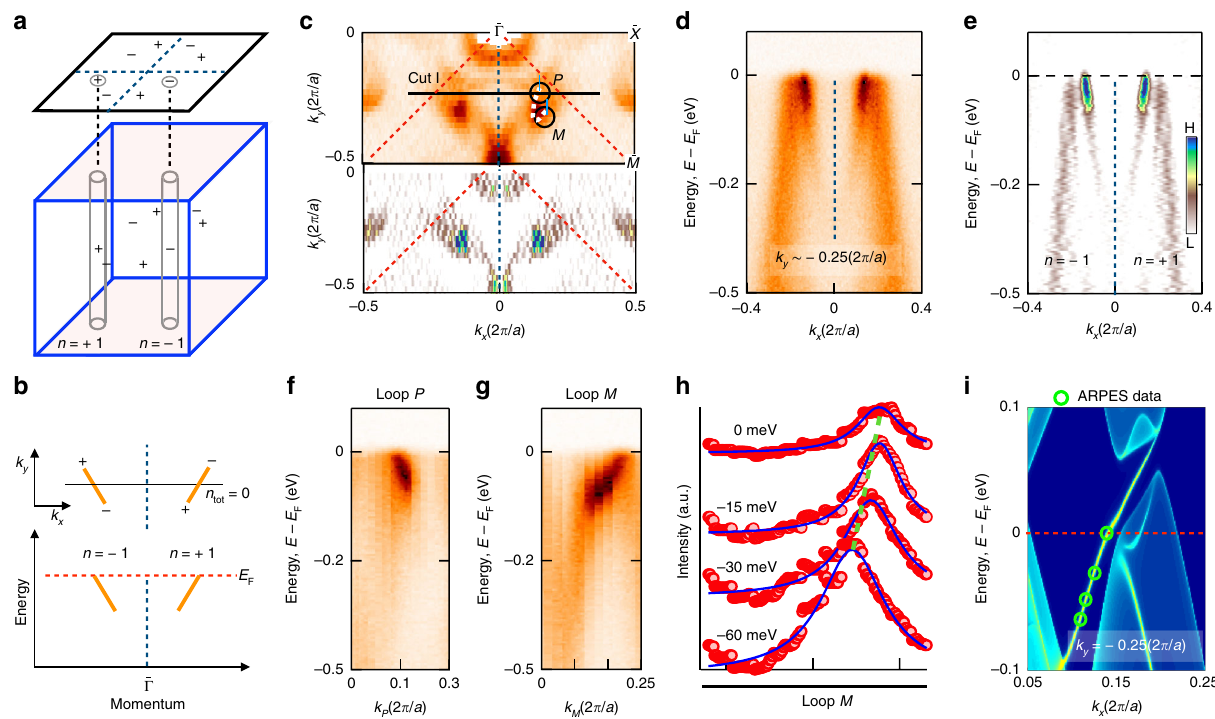
Fig. 3 Observation of topological Fermi arcs and chiral charges in PrAlGe. a Bulk and surface Brillouin zone (BZ) with the Weyl fermions (±) and manifolds with Chern number n 32 . A closed loop enclosing the projected chiral charge in the surface corresponds to a cylinder in the bulk enclosing the Weyl fermion. b Top: topological Fermi arcs (orange) connecting the projected Weyl fermions carrying chiral charge ±1. Bottom: a cut across two arcs (along the black line in top panel) with chiral edge modes (orange lines). c Top panel: Fermi surface obtained by ARPES at T ≈ 11K. Loop cuts of interest ( P and M ) are illustrated with black loops with the starting/end points marked by the vertical blue line. Bottom panel: 2D curvature plot of the above Fermi surface. d Measured band dispersion along horizontal Cut I. Blue dashed line: indicates the mirror symmetry. e Second-derivative plot of d . f ARPES- measured band dispersion along the loop P . Loop P encloses the termination point of the measured Fermi arc and shows a single left-moving chiral mode, corresponding to an enclosed Chern number n = − 1. g Band dispersion along loop M . The observed right-moving chiral mode shows an enclosed Chern number n = + 1. h Stack of MDCs along loop M at different binding energies, with Lorentzian fi ts. Green dashed line: guide to the eye tracking the peaks. i Calculated energy dispersion along k y = − 0.25 (2 π / a ) with the result from our ARPES spectra overlaid (open green k ≈ − 0.25 (2 π / a ) passes through a pair of “ U ” states, Fig. 3c, d. y